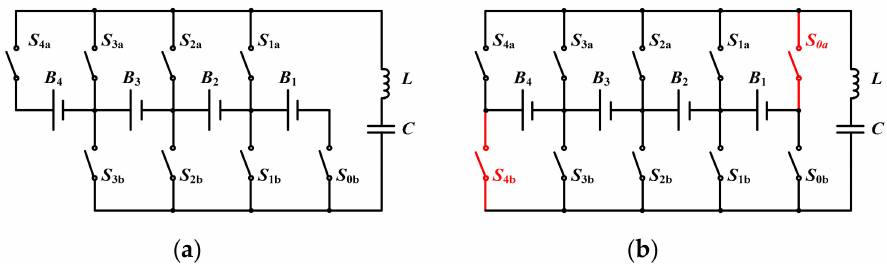
Figure 4. Circuit comparison of MC2MC equalizers. ( a ) The equalizer based on HBLCC [23]. ( b ) The proposed equalizer based on BRLCC.